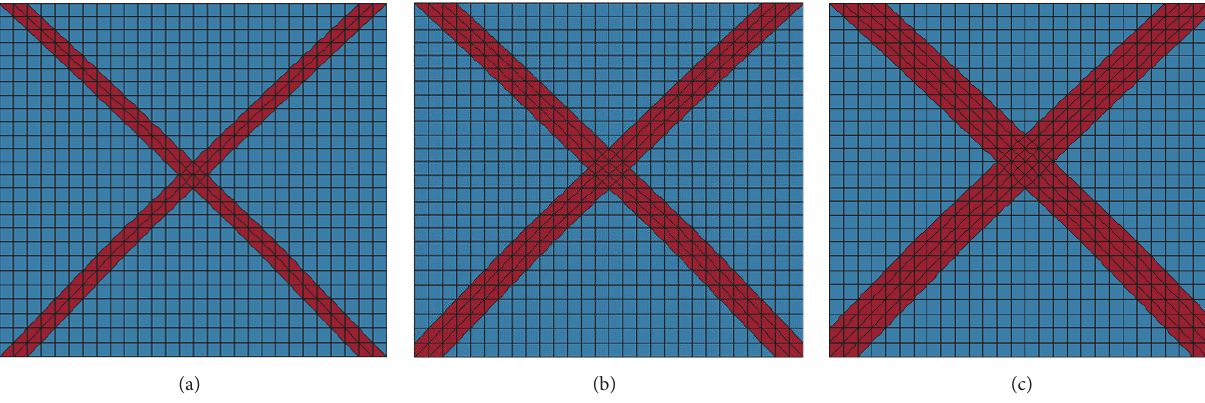
Figure 12: Carbon fiber layouts: (a) model 4, (b) model 5, and (c) model